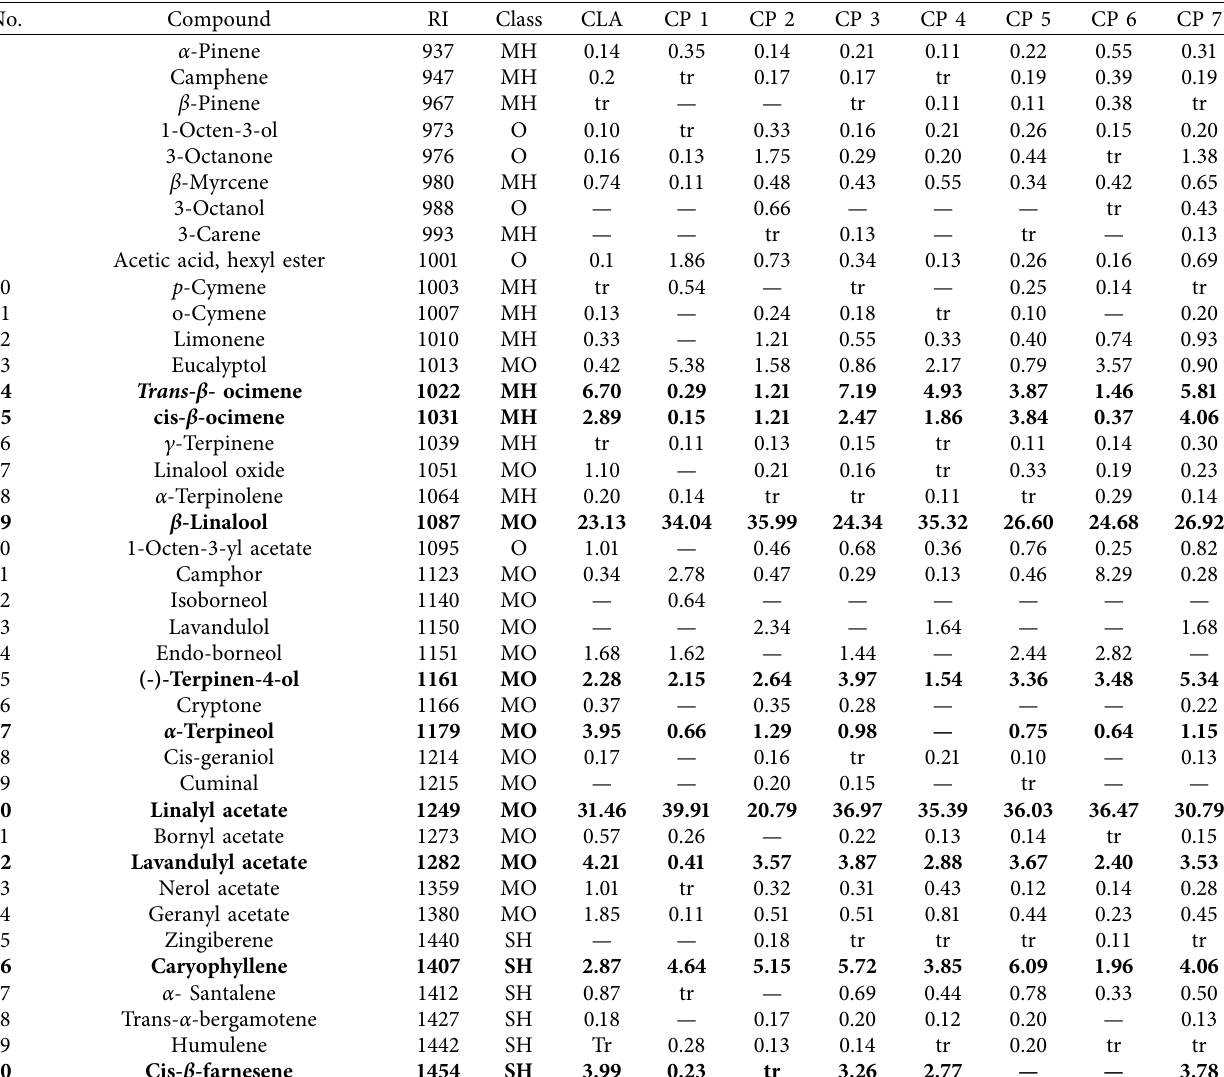
Table 1: Te GC data for essential oil components identifed in cultivated L. angustifolia and commercial products, where tr indicates traces, less than